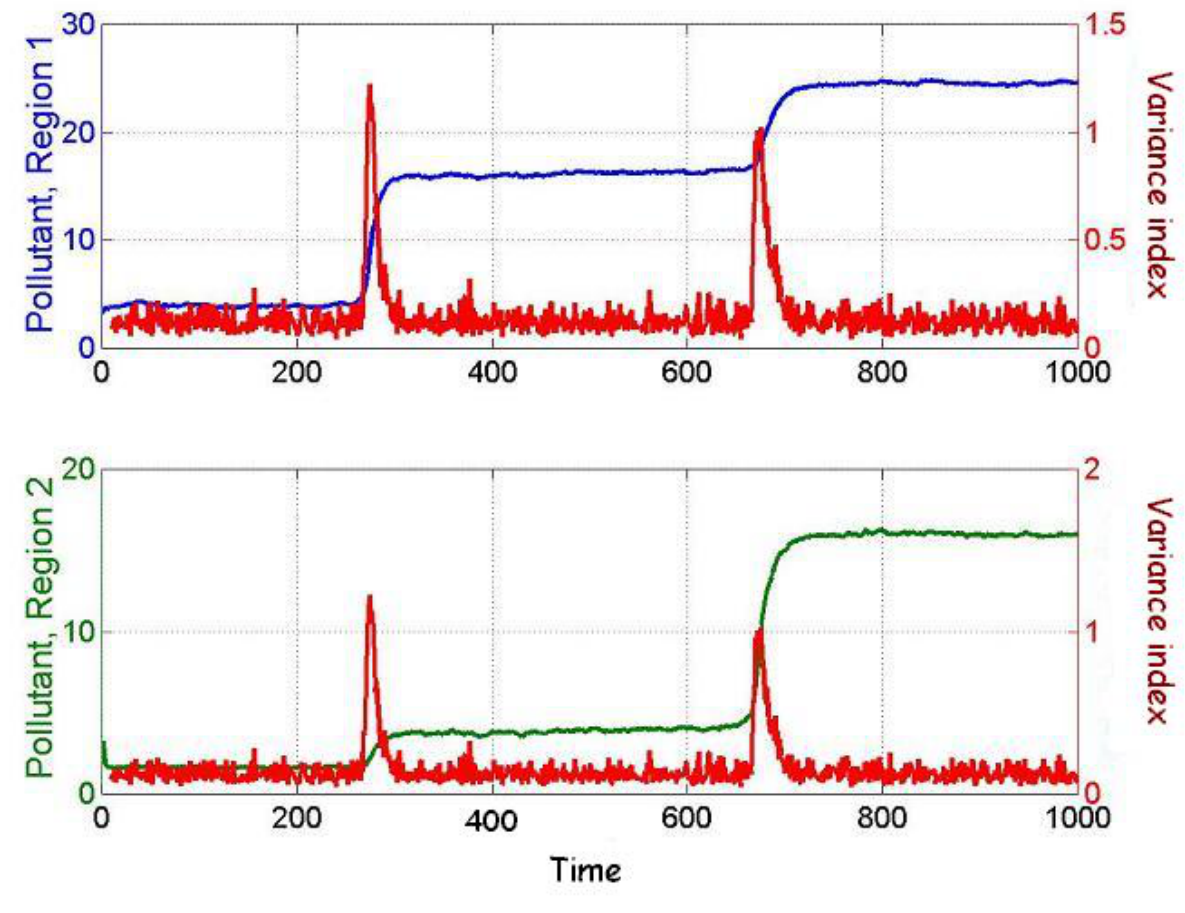
Fig. 7 . Pollutant in region 1 and variance index (upper panel) and pollutant in region 2 and variance index (lower panel) for the simulation shown in Fig.